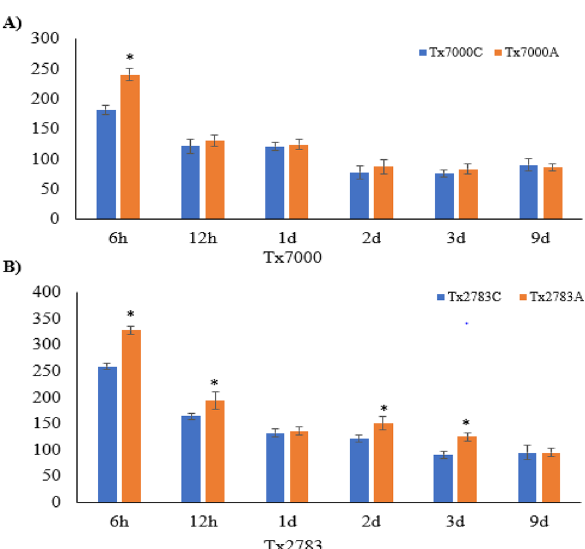
Figure 3. Gene expression analysis of five SbPAL genes ( PAL1 , PAL2, PAL3, PAL15, and PAL7 ) in controls and sugarcane aphid (SCA) infested shoot tissues from two sorghum lines (Tx7000, Tx2783). qRT-PCR was used to determine the relative expression of each SbPAL gene, and the relative expression was estimated using the 2 −ΔΔCt method. Samples were collected at 6 hours post infestation (h), 12 h, 1 day post infestation (d) 2 d, 3 d, 6 d, and 9 d. Gene expression in control (none-infested) plants of each line is normalized to 1. Error bars represent standard error among replicates (n = 3) and the asterisks represent statistically significant changes between the controls and SCA infested samples as determined using Student’s t-test ( p ≤ 0.05), while the bars without asterisk are non-significant ( p > 0.05).